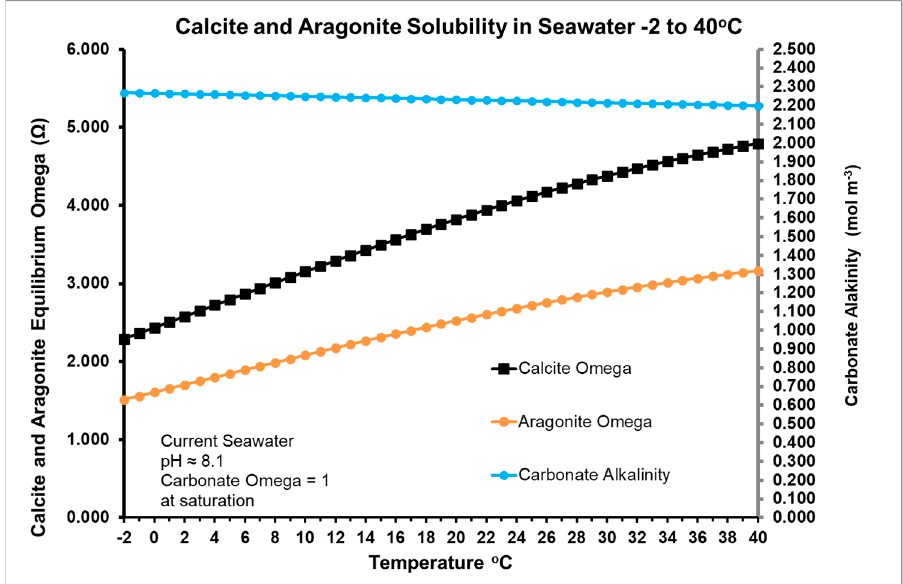
Figure 3. Estimated variation of calcite and aragonite solubility in seawater from − 2–40 °C for year 2022 CE and Keeling p CO 2 of 421 ppm. Contact RJR if you require a copy of the Excel spreadsheet used for this plot. Omega ( Ω ) calculations are based on estimates of Ca 2+ and carbonate activity from the Debye-Hückel theory.